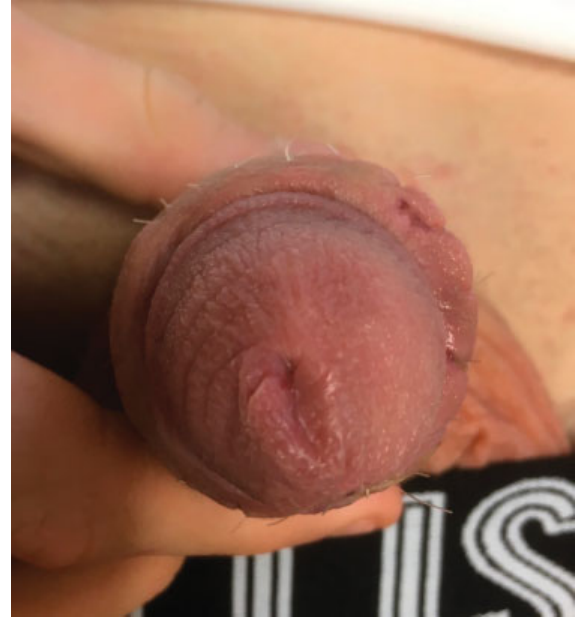
Fig. 4 After treatment, glans ischemia resolved completely (seventh postoperative day after